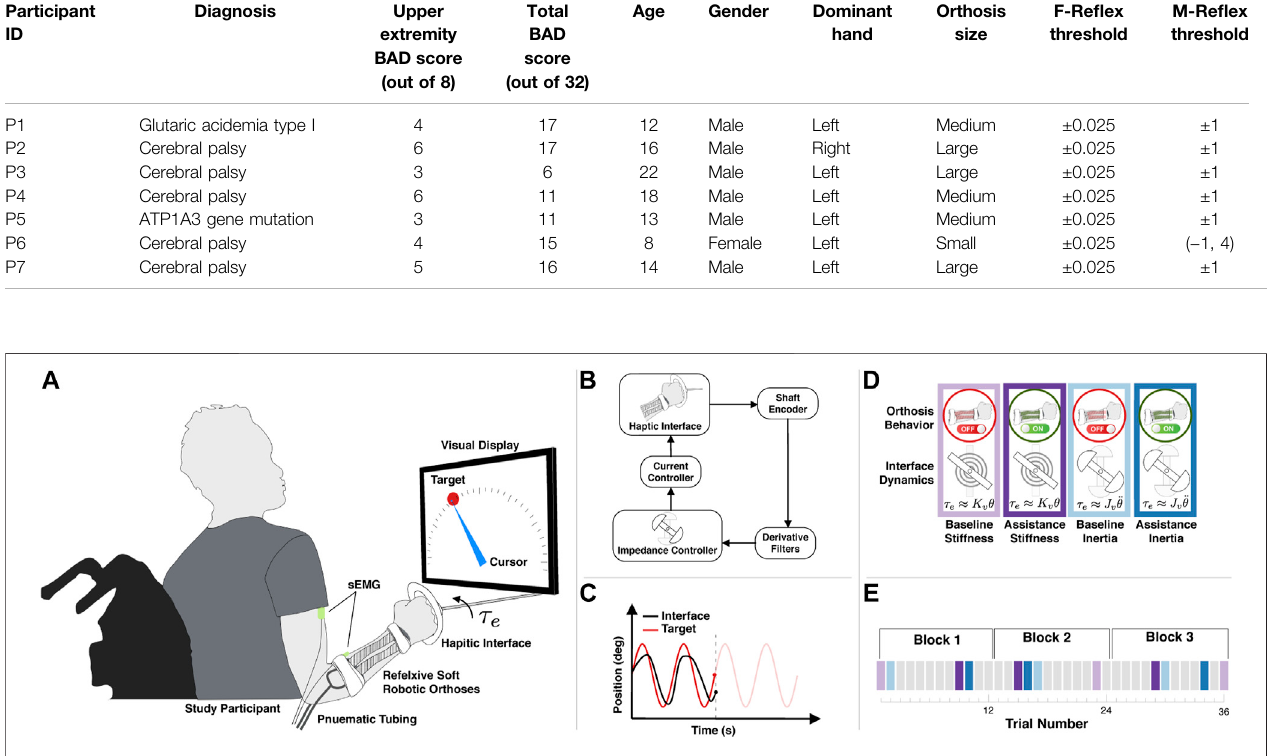
FIGURE 5 | An overview of the experimental design. (A) The experiment consists of a participant with the soft wearable robot interacting with a one-degree-of- freedom rotational haptic interface. The total external torque τ e depends on the haptic environment ( Eq. 5 ). For each trial, the goal is to track the moving target with the cursor, directly controlled by the haptic interface. A display provides the participant with visual feedback of the target (red circle) and cursor (blue pointer) positions. The haptic interface supplies an external torque τ e determined by either Stiffness-Dominate or Inertia-Dominate dynamics. (B) The haptic interface uses an impedance controller with an optical encoder on the shaft, providing the requisite feedback to render the appropriate torque at the interface. (C) A sample trial illustrating typical target (red) and interface (black) trajectories. In this study, the target trajectory consists of 15 cycles of a 0.2 Hz sinusoid with the amplitude spanning ± 80 ° . (D)